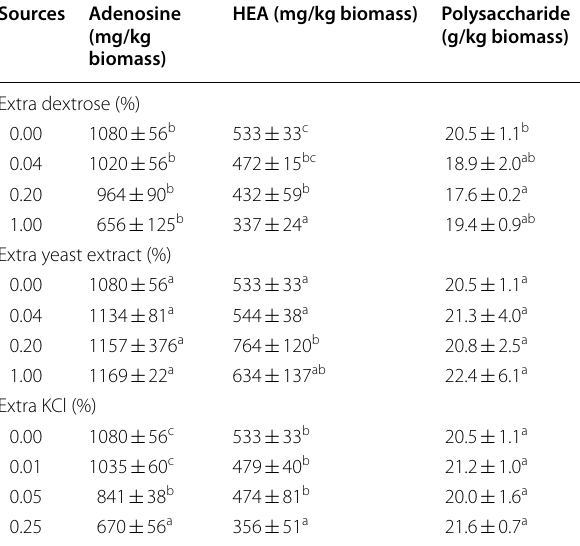
Table 4 Effect of different concentration of dextrose, yeast extract and KCl on adenosine, HEA and polysaccharide in 100-mL submerged-fermented C. cicadae NTTU868